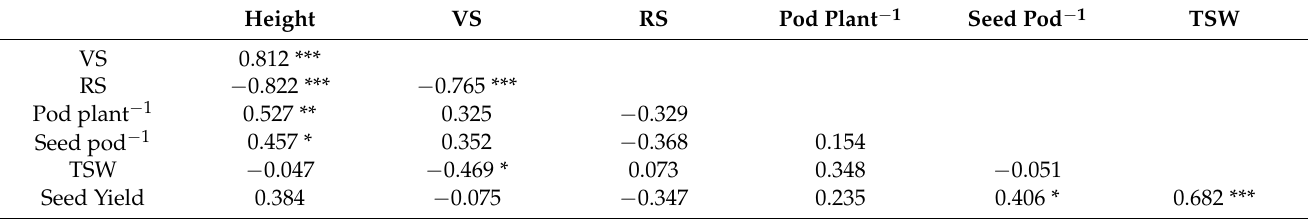
Table 1. Pearson correlation coefficients (r) among growth stage (vegetative and reproductive stages, VS and RS, respectively), morphology (plant height), yield, and yield components of six white